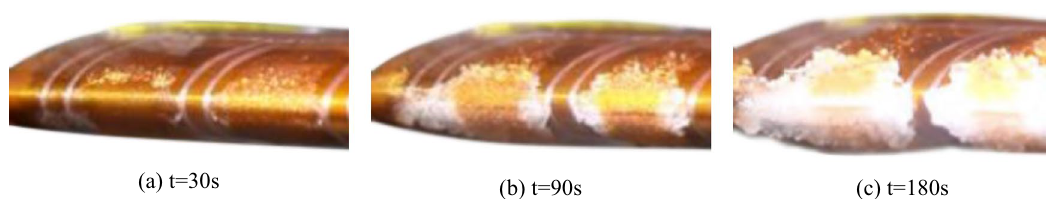
Figure 2. The process of plasma ice shape regulation at different moments 28